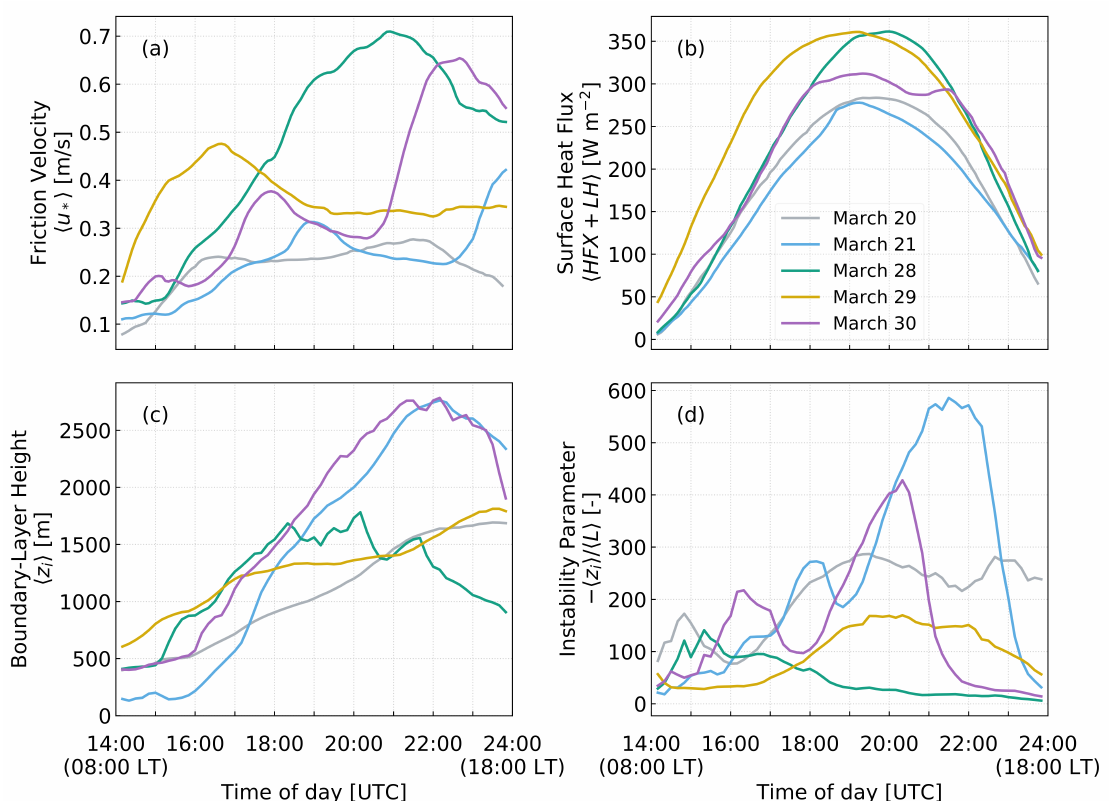
Figure 4. Diurnal evolution of friction velocity, upward surface heat flux, boundary layer height and instability parameter. Shown for each diurnal cycle considered in the analysis and obtained from the reference simulation RLES. The values are spatial averages within a box that is centered in the innermost domain and spans 15 km × 15 km horizontally.